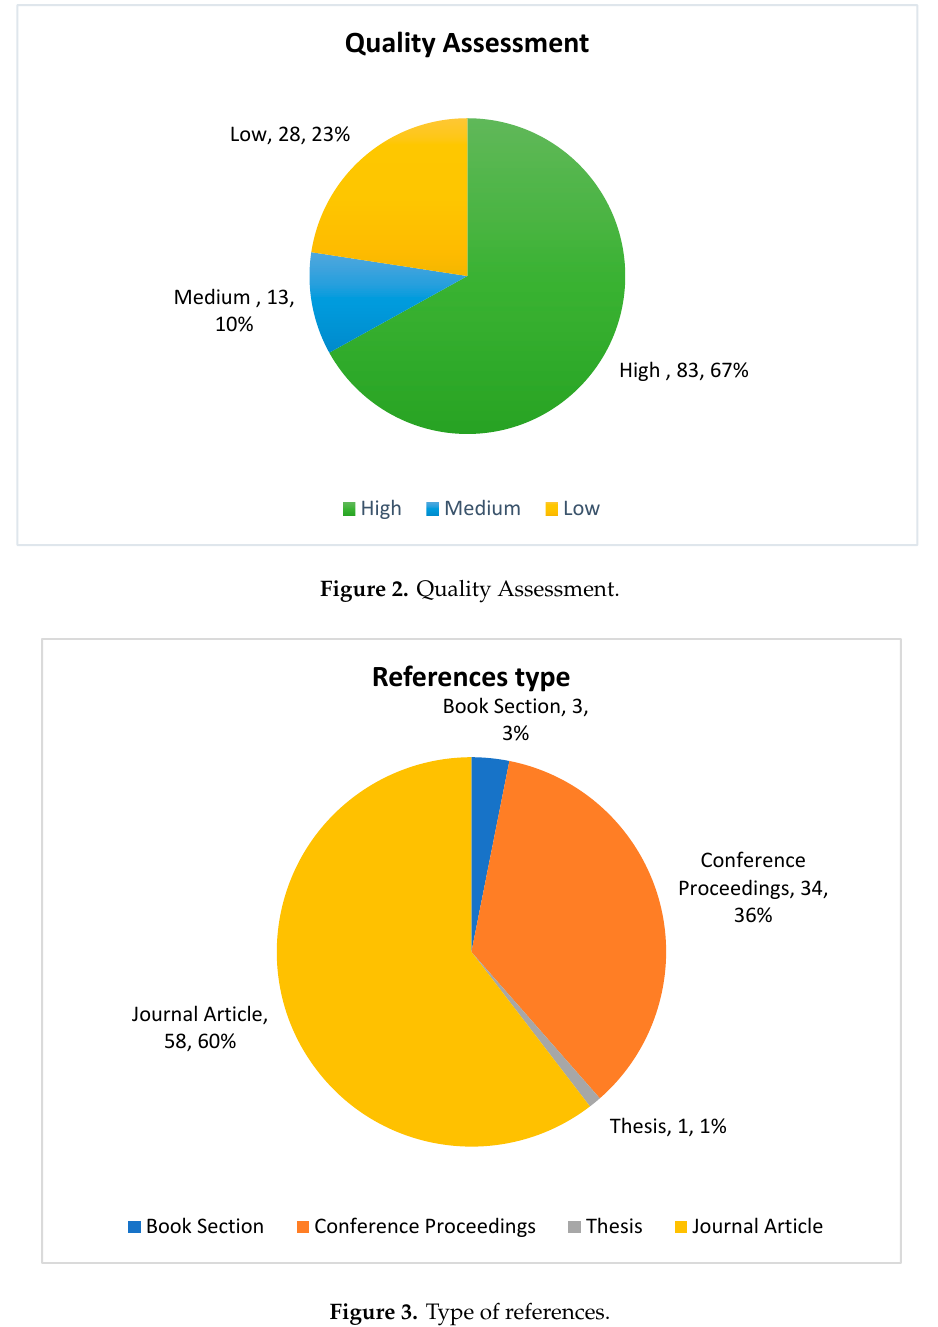
Figure 4. Research methodology. 2.5.1. Publications Source Overview The majority of the primary studies were published and cited in journals and conferences. Figure 3 presents the distribution of these studies derived from their publication sources. It shows that the primary studies included 63 journal articles (58%), 40 conference reports (38%), three book chapters (3%), and one thesis (1%). 2.5.2. Research Methodologies